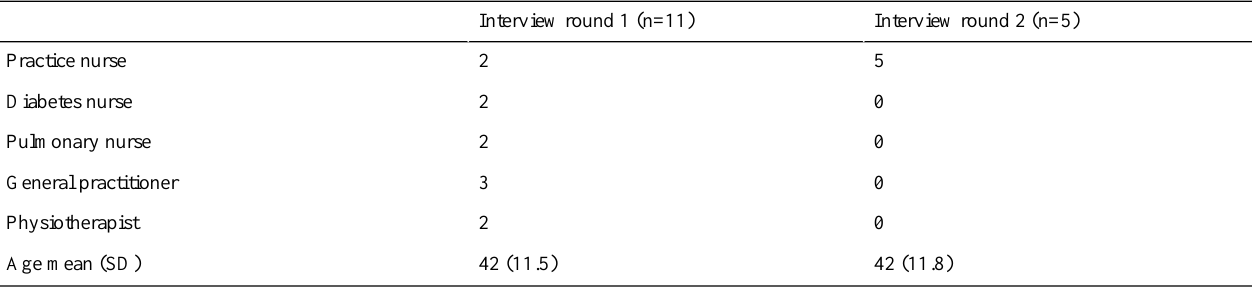
Table 4. Characteristics of health professional respondents from the interviews and focus groups.